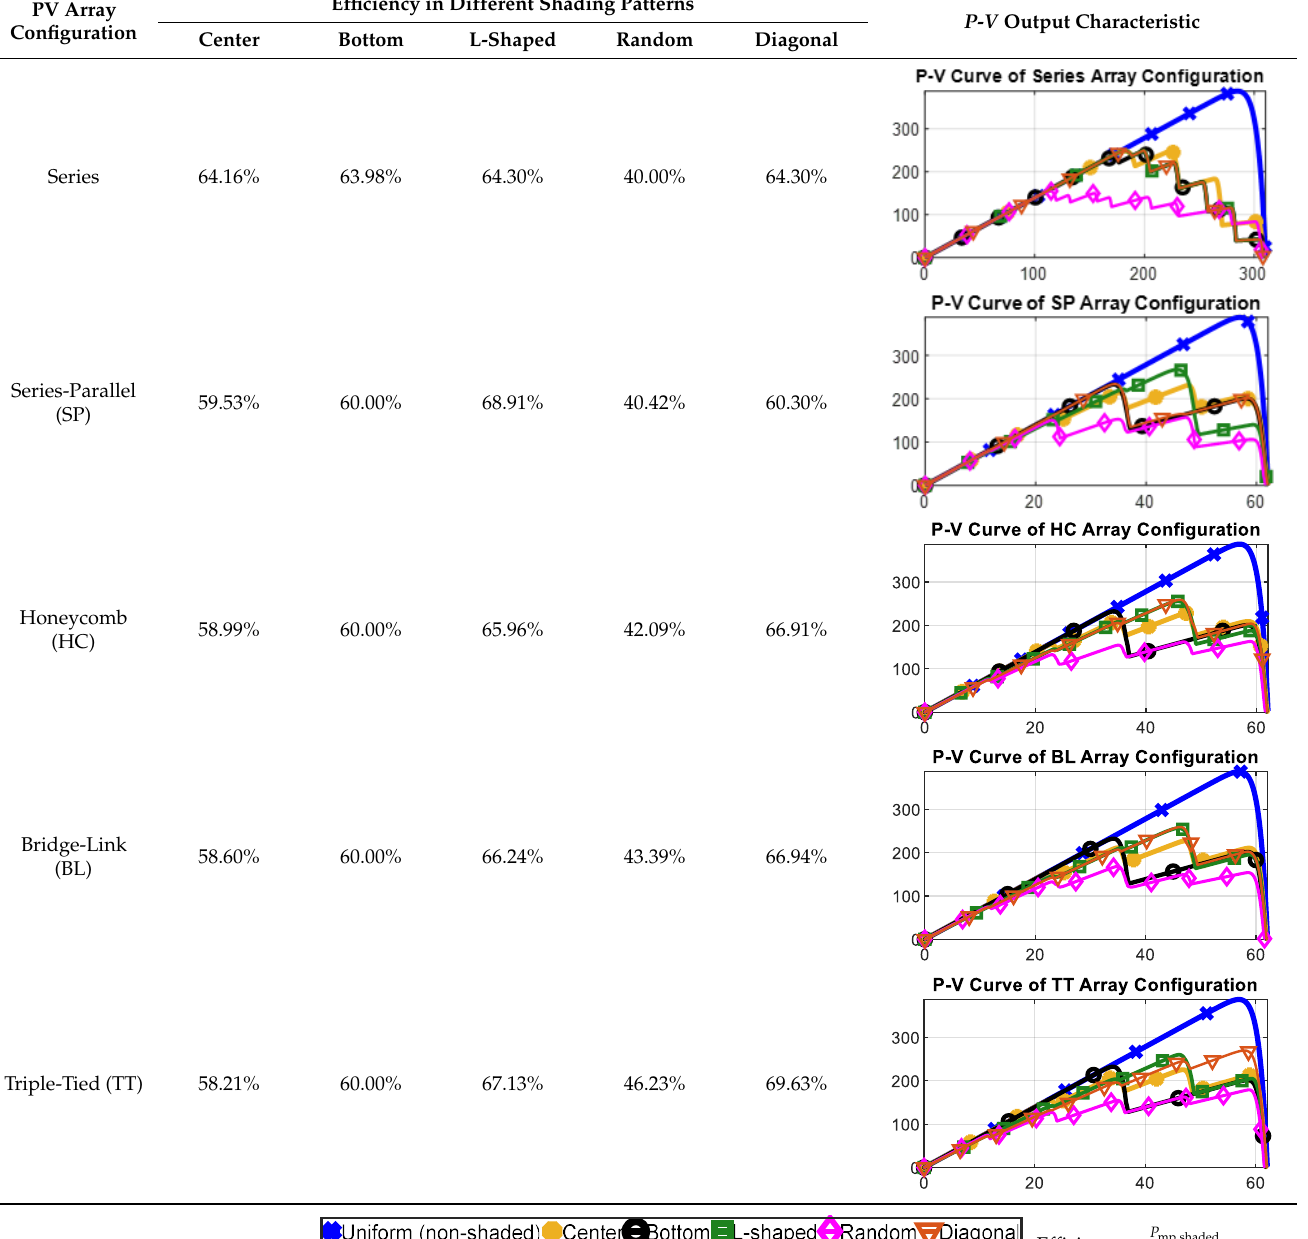
Table 7. Summary of output characteristics and efficiencies for different array configurations in various shading patterns.